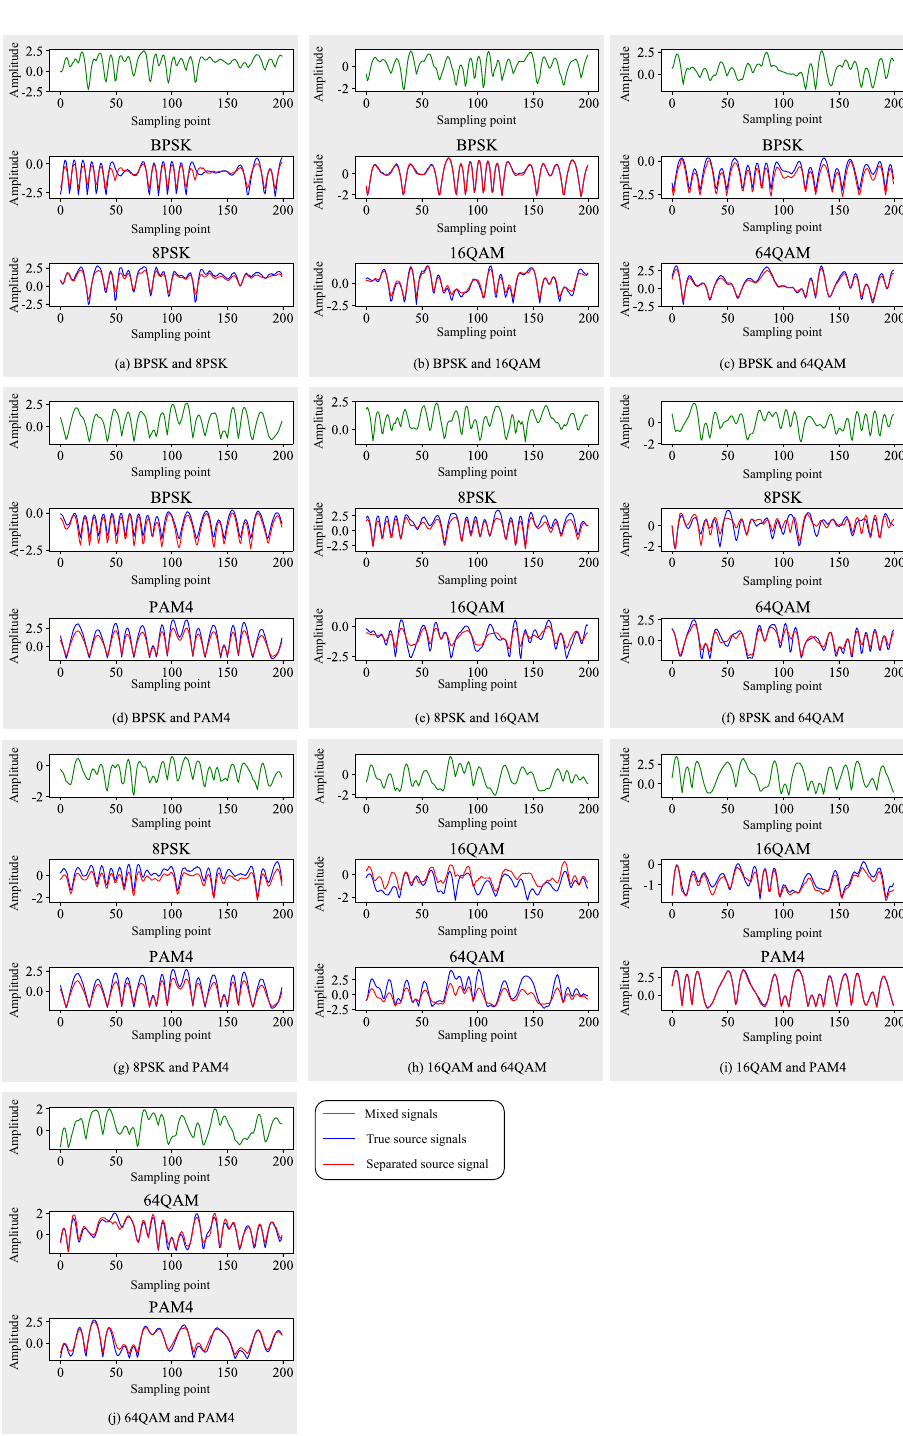
Figure 6. Separated signals waveform (SNR = 15 dB) (200